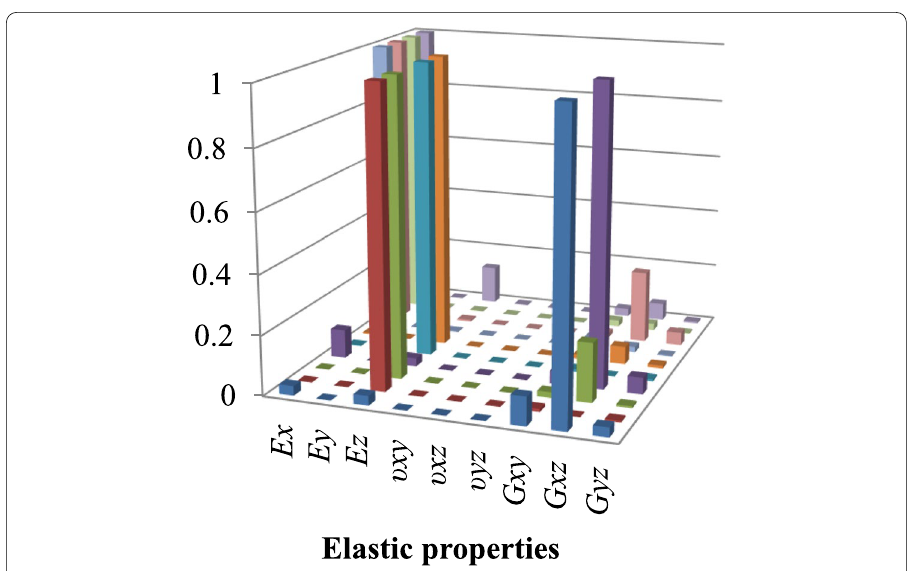
Fig. 19 Sensitivity analysis for